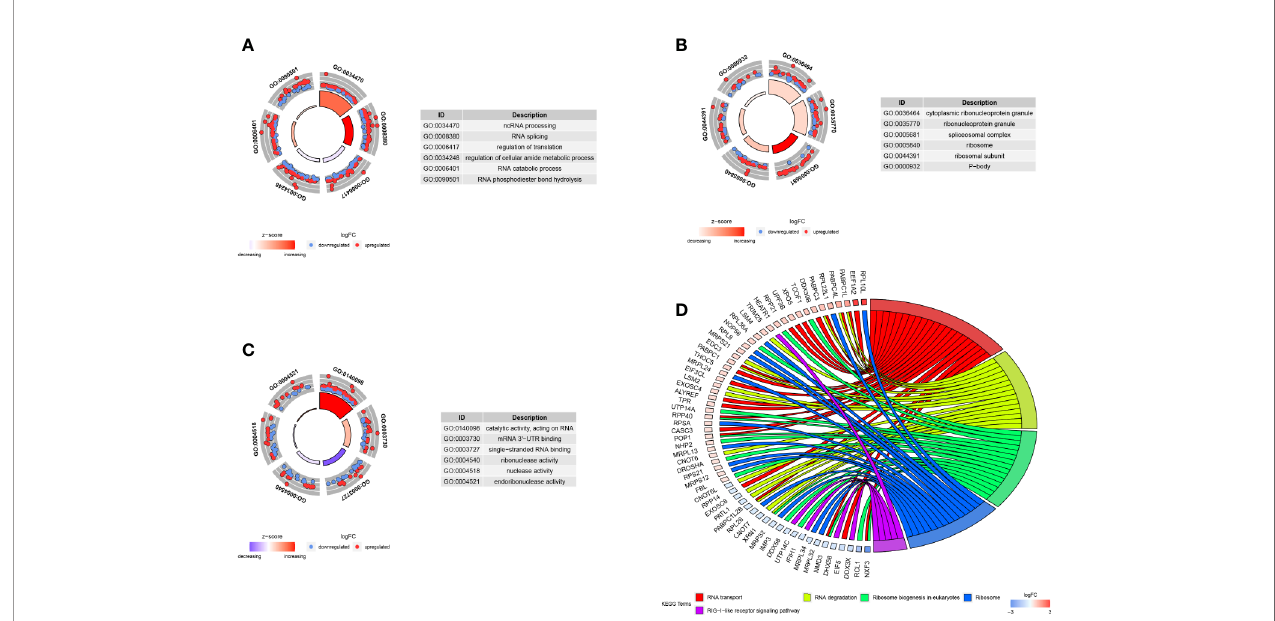
FIGURE 2 | GO and KEGG enrichment analyses of DE RBPs. (A – C) Top six enriched GO terms respectively enriched in Biological processes (BP), Cellular components (CC), and Molecular functions (MF); (D) Five signi fi cantly enriched KEGG pathways for DE RBPs. The outer circle shows a scatter plot for each term or pathway of the logFC of the assigned genes, red circles represent up-regulation and blue represent